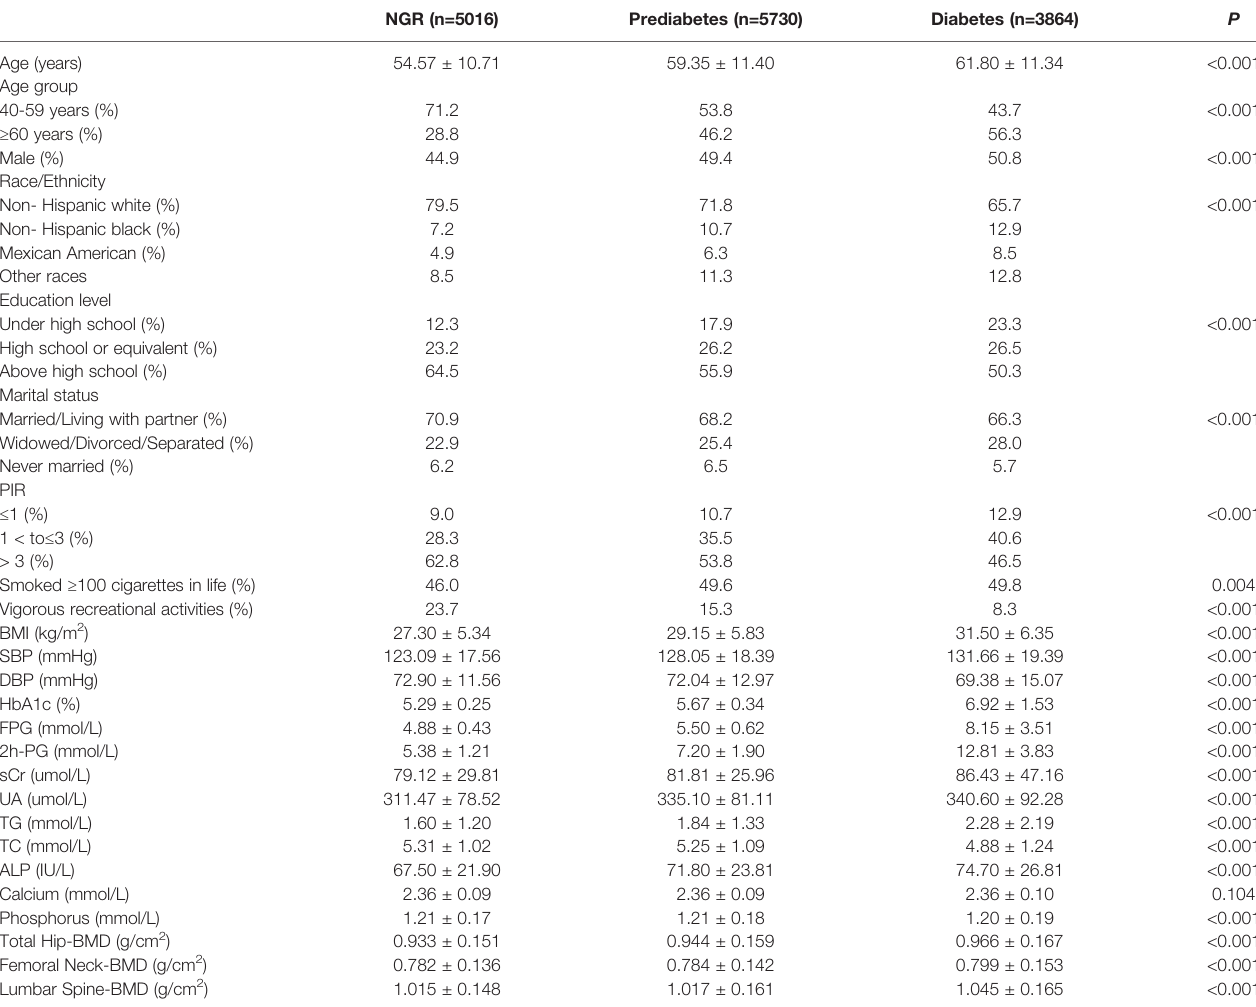
TABLE 1 | Weighted characteristics of US adults ≥ 40 years old with NGR, prediabetes and diabetes,